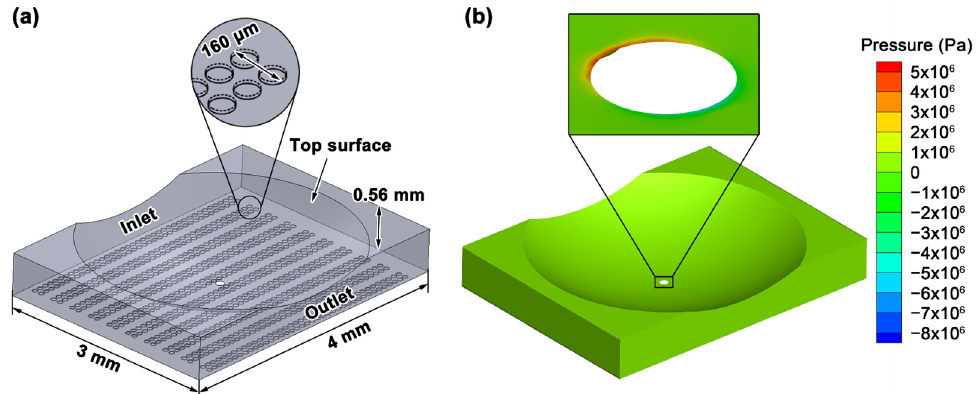
Figure 7. Schematic of ( a ) the flow domain of the CFD model and ( b ) the pressure distribution in the flow domain.